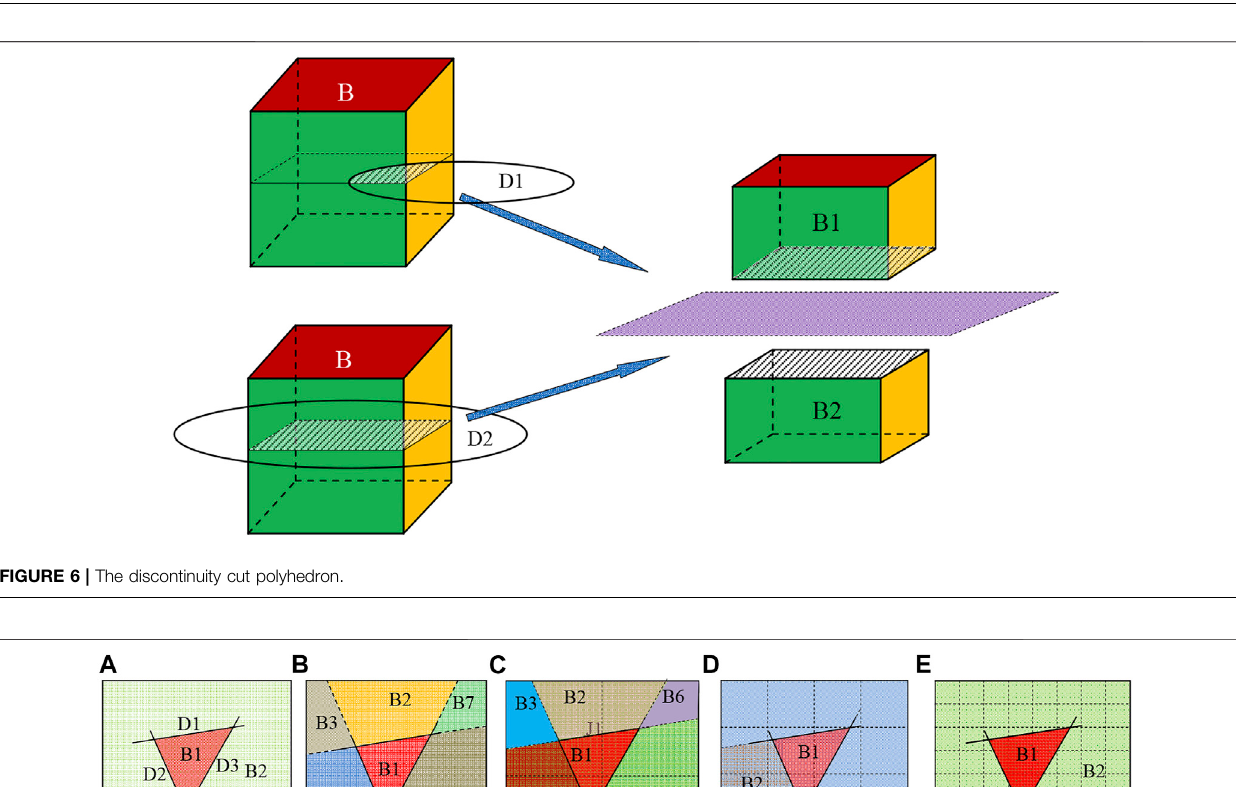
FIGURE 7 | The comparison between traditional and meshing algorithm. (A) The actual result. (B) Traditional algorithm. (C) Four-element blocks. (D) Sixteen- element blocks. (E) Sixty-four-element blocks.